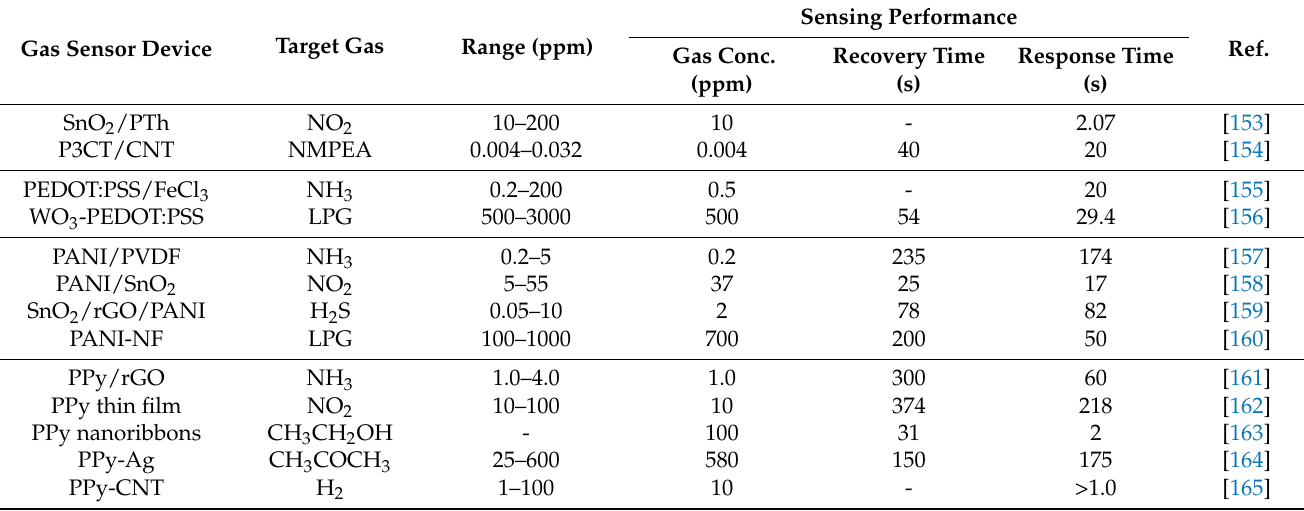
Table 3. Chemiresistors based on polythiophene (PTh), poly-(3,4-ethylenedioxythiophene) (PEDOT), polyaniline (PANI), and polypyrrole